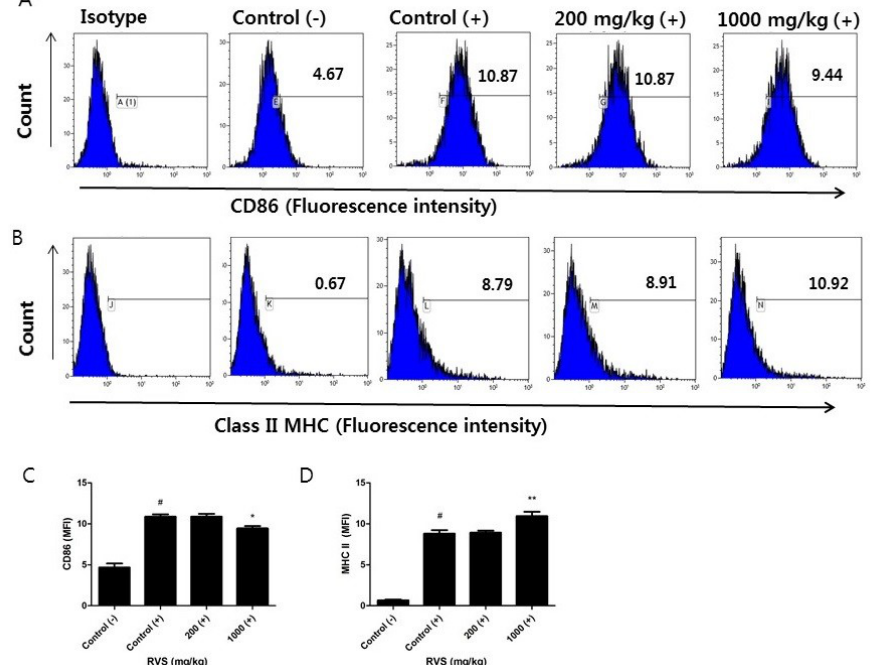
Figure 5 . Effects of RVS extract on surface expression of CD86 and class II MHC in LPS-stimulated peritoneal macrophages. Adherent peritoneal macrophages from the control and RVS-treated mice were stimulated with LPS for 24 h and surface expression of CD86 and class II MHC molecules was determined via flow cytometry. ( A , B ) Representative histograms are shown. ( C , D ) The bars represent the mean ± SEM ( N = 6). ( − ): without LPS, (+): with LPS. Statistical differences between groups were determined using one-way ANOVA with Tukey’s test. # p < 0.005 vs. control ( − ). * p < 0.05, ** p < 0.01 vs. control